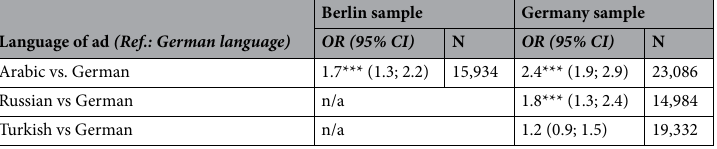
Table 2. Logistic regression model assessing likelihood of clicking on COVID-19 vaccine advertisement by ad language and campaign location, November and December 2021. Note: Each cell based on separate weighted logistic regression model. Significance levels at * p < 0.10, ** p < 0.05 , *** p < 0.01.